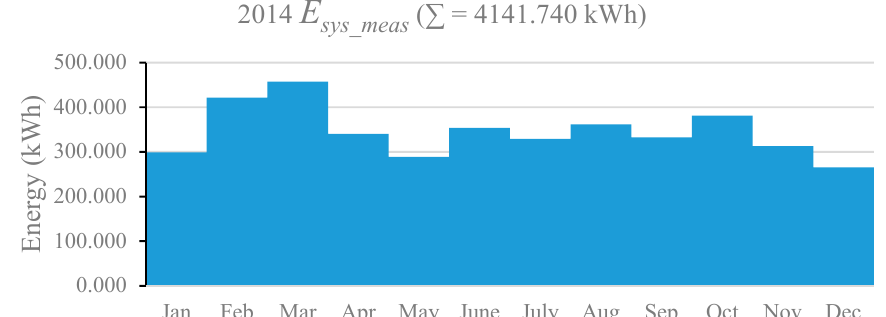
Figure 10. Energy produced from a real 3 kW PV system in 2014. Table 11. Validation results of E sys with different types of PV inverter efficiencies.